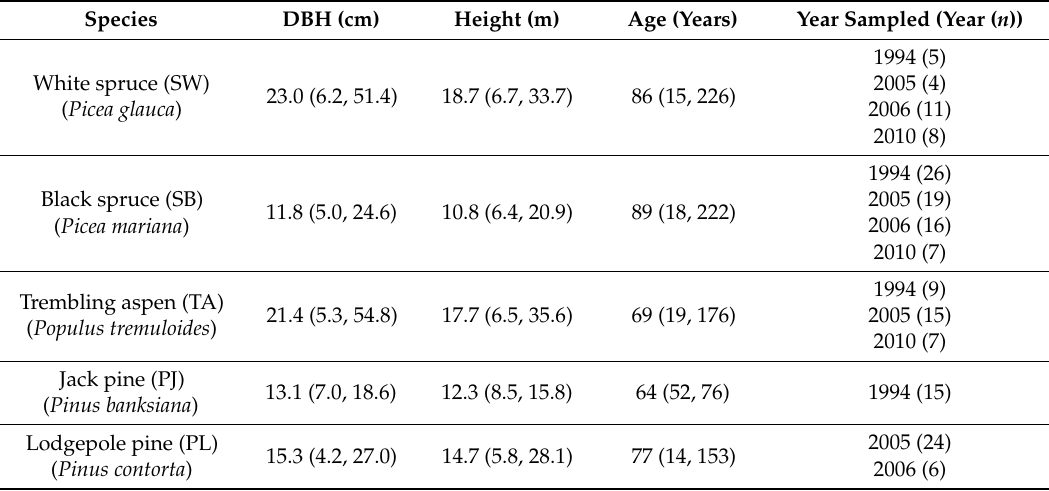
Table 1. Summary of characteristics of trees sampled for stem analysis in this